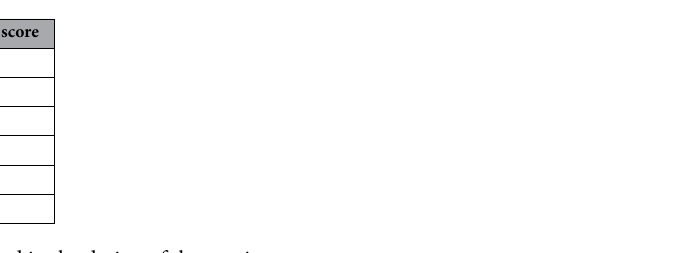
Table 1. Details of the proteins used in the design of the